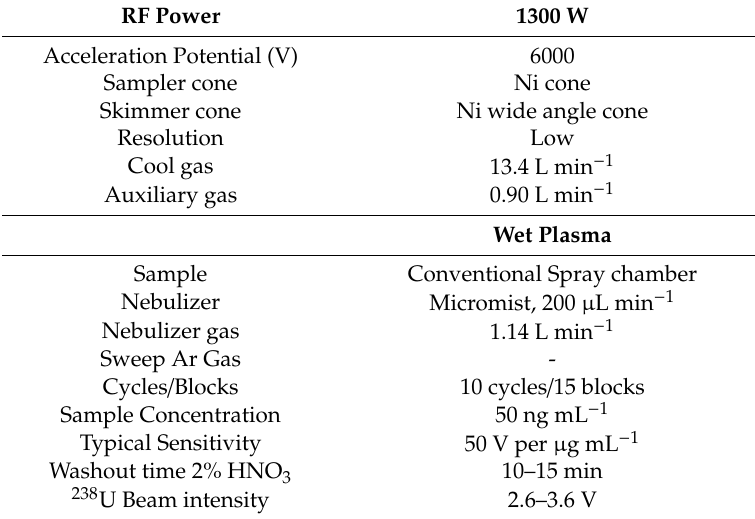
Table 3. Multi-collector inductively coupled plasma mass spectrometer (MC-ICP-MS) operating and measurement